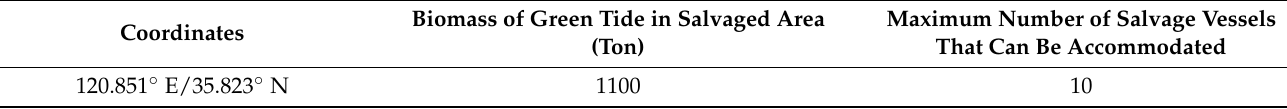
Table 2. Detailed information of salvage